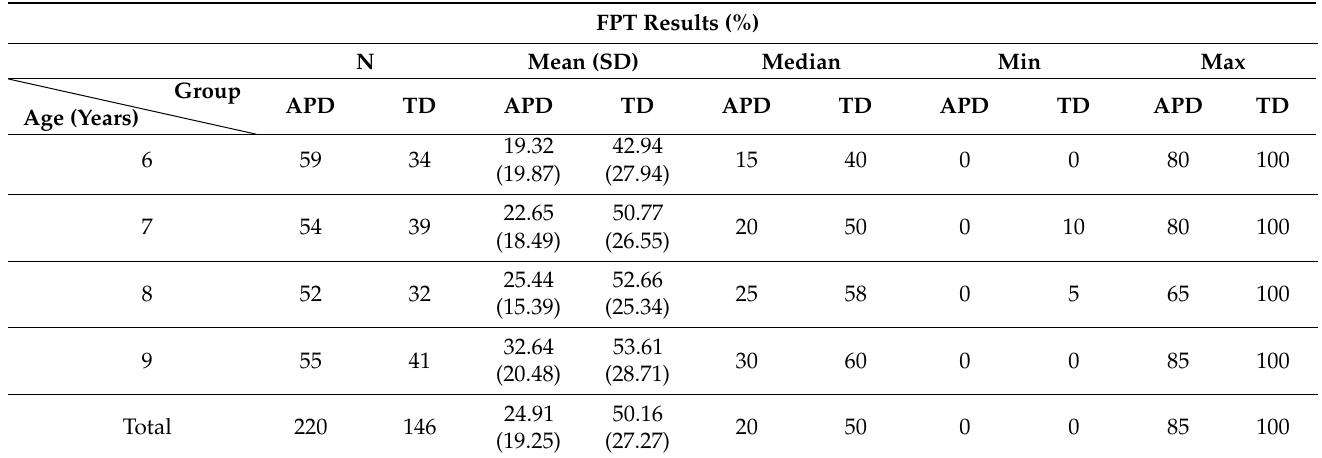
Table 3. Basic statistics describing the Frequency Pattern Test (FPT) results in the APD and TD groups by age.